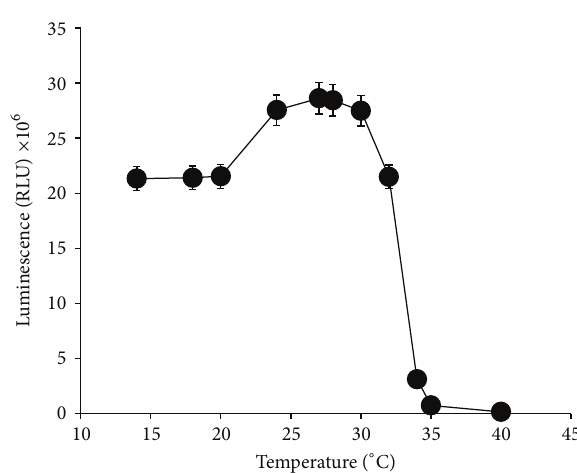
Figure 8: Effects of different temperatures on bioluminescence pro- duced by Photobacterium sp. strain MIE. The cultures were grown in luminescence media at different temperatures and incubated in an orbital shaker (100rpm) for 12 hours. Data is mean ± standard error of the mean ( 𝑛 = 3 ).